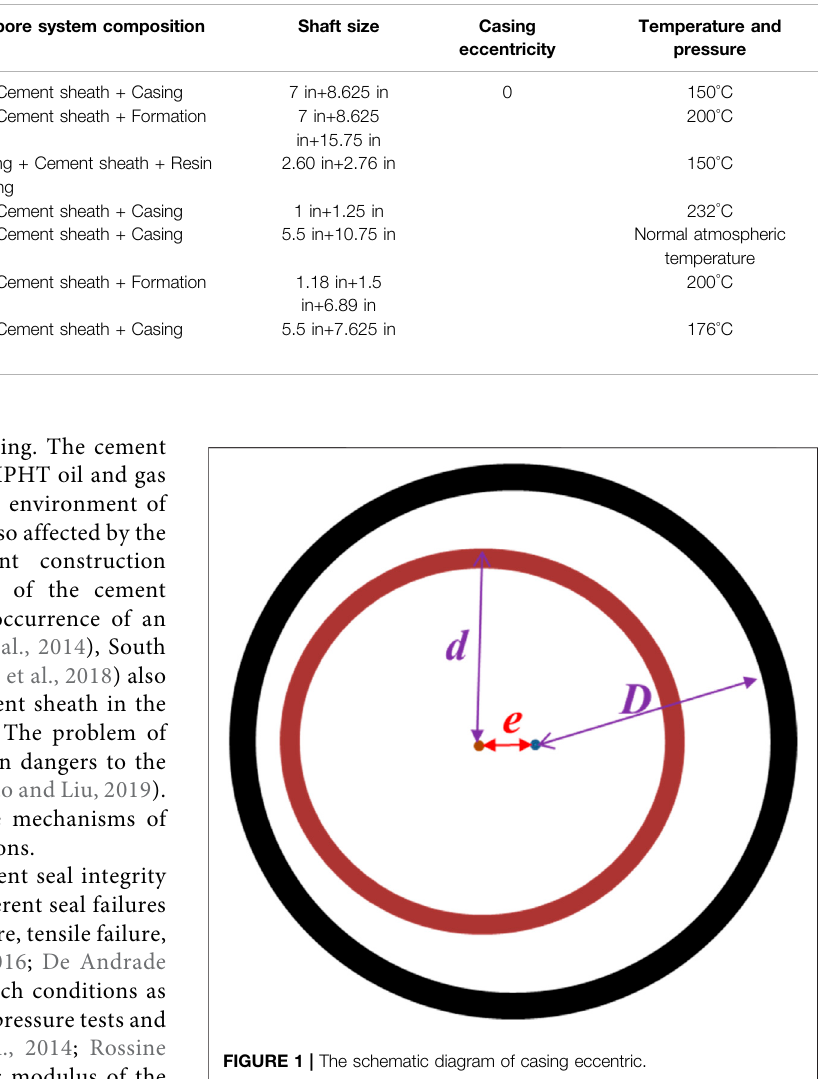
TABLE 1 | Cement sheath seal failure evaluation device.